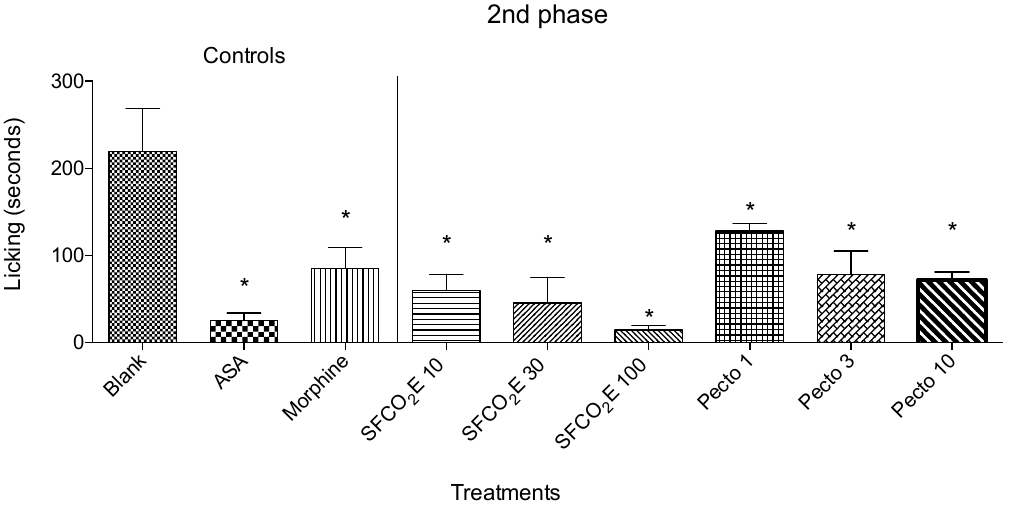
Figure 3. The results from the second phase of formalin of treated mice (SFCO 2 E at 10, 30, and 100 mg/kg or pectolinarigenin at 1, 3, and 10 mg/kg) were compared with mice that were given vehicle (blank), ASA (200 mg/kg) and morphine (2.5 mg/kg) used as positive controls. This figure shows the decrease of the bar against the untreated mice. The treatments which show a significant decrease in the bar size compared to blank are marked with (*), p < 0.05.